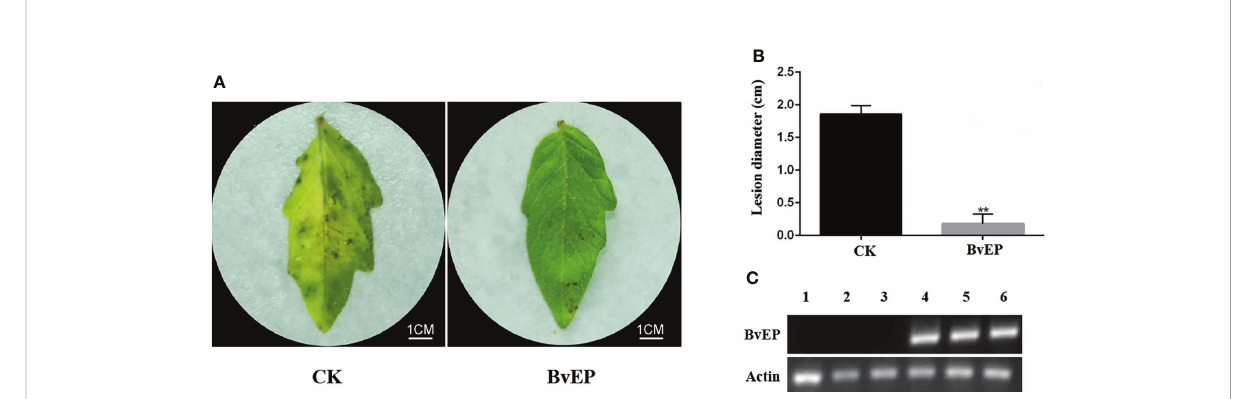
FIGURE 2 Effects of BvEP transient transformation on tomato leaves after inoculation with B. cinerea . (A) Phenotype of tomato systemic leaves inoculation at 3 DAI with B.cinerea ; leaves were treated as follows before inoculation: CK represented pK7LIC4.0 in fi ltration, BvEP represented pK7LIC4.0- BvEP in fi ltration; (B) Lesion diameter of tomato at 3 DAI with B. cinerea , asterisks indicate statistically signi fi cant differences (** p < 0.01). (C) Expression of BvEP mRNA in tomato leaves at 3 DAT with pK7LIC4.0 and pK7LIC4.0-BvEP; 1, 2, 3 are pK7LIC4.0; 4, 5 and 6 are pK7LIC4.0-BvEP.